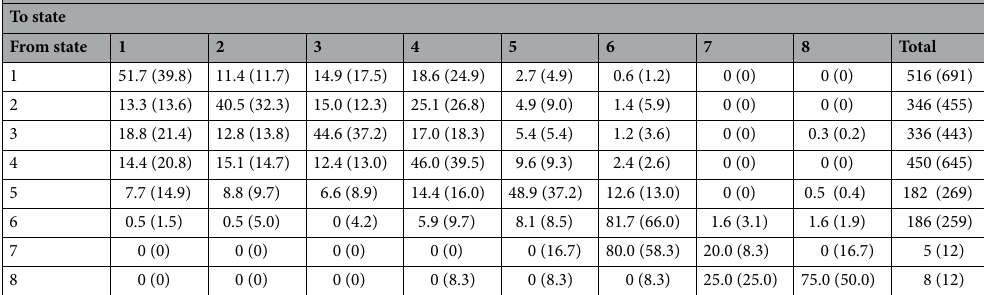
Table 1. EDSS transition percentages (%) before (after) imputation. The EDSS levels were categorised into disability states as: 1 = EDSS (0–1.5), 2 = EDSS (2–2.5), 3 = EDSS (3–3.5), 4 = EDSS (4–4.5), 5 = EDSS